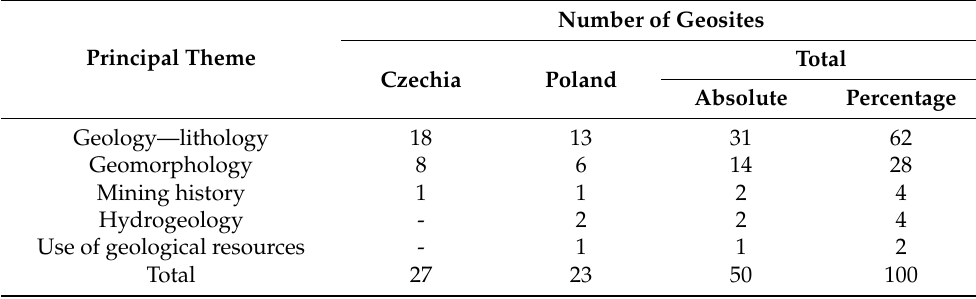
Table 3. Summary of geosites in the study area, classified by the principal